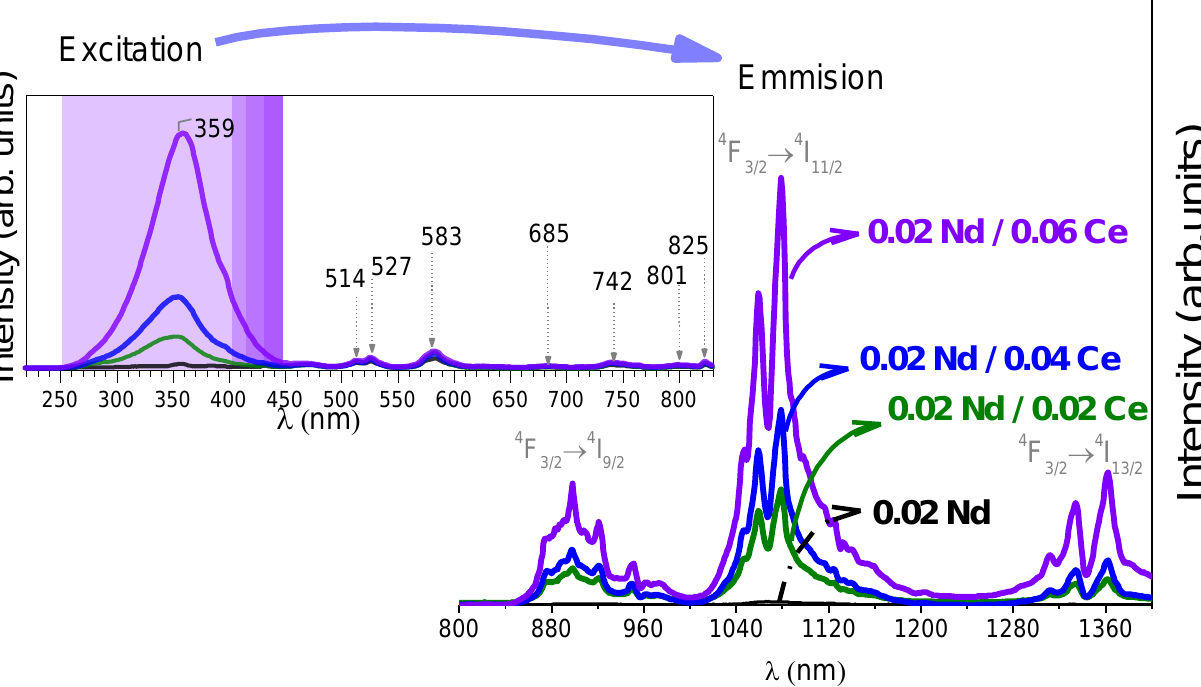
Figure 9. Excitation and emission spectra of the synthesized nanofibers based on ZnAl 2 O 4 :Nd, Ce. To determine cell viability, MTT assays are usually performed. In the case of the ZnAl 2 O 4 : nanofibers doped with Nd and co-doped with Ce obtained using sol-gel synthe- sis, HeLa cells were employed. On the other hand, for ZnAl 2 O 4 : fibers doped only with Nd obtained by electrospinning, BMSCs were used as model human